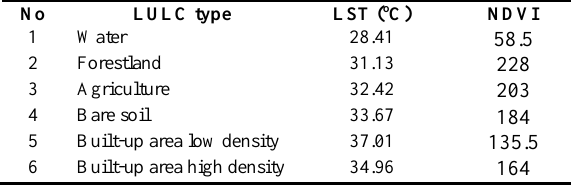
Table 5. Values of LST and NDVI at different LCLV type in